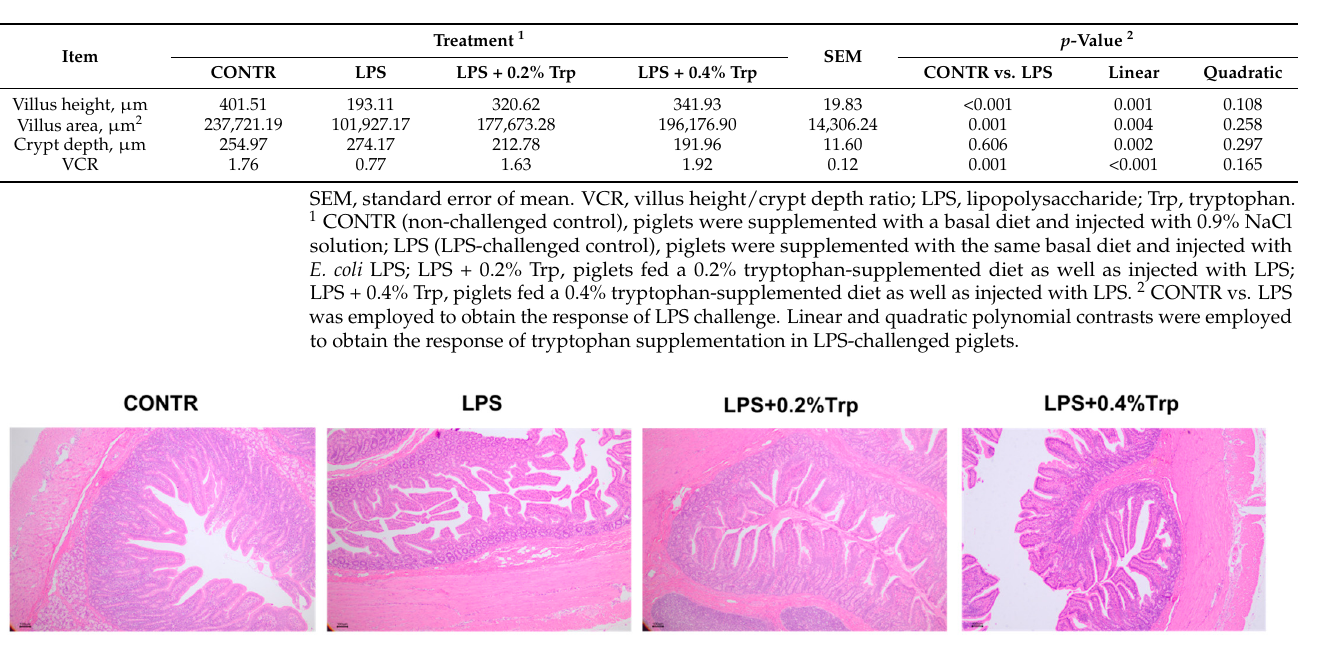
Figure 1. Effect of tryptophan supplementation on ileal morphology after 4 h LPS challenge in piglets. CONTR, control; LPS, lipopolysaccharide; Trp, tryptophan. CONTR (non-challenged control), piglets were supplemented with a basal diet and injected with 0.9% NaCl solution; LPS (LPS-challenged control), piglets were supplemented with the same basal diet and injected with E. coli LPS;